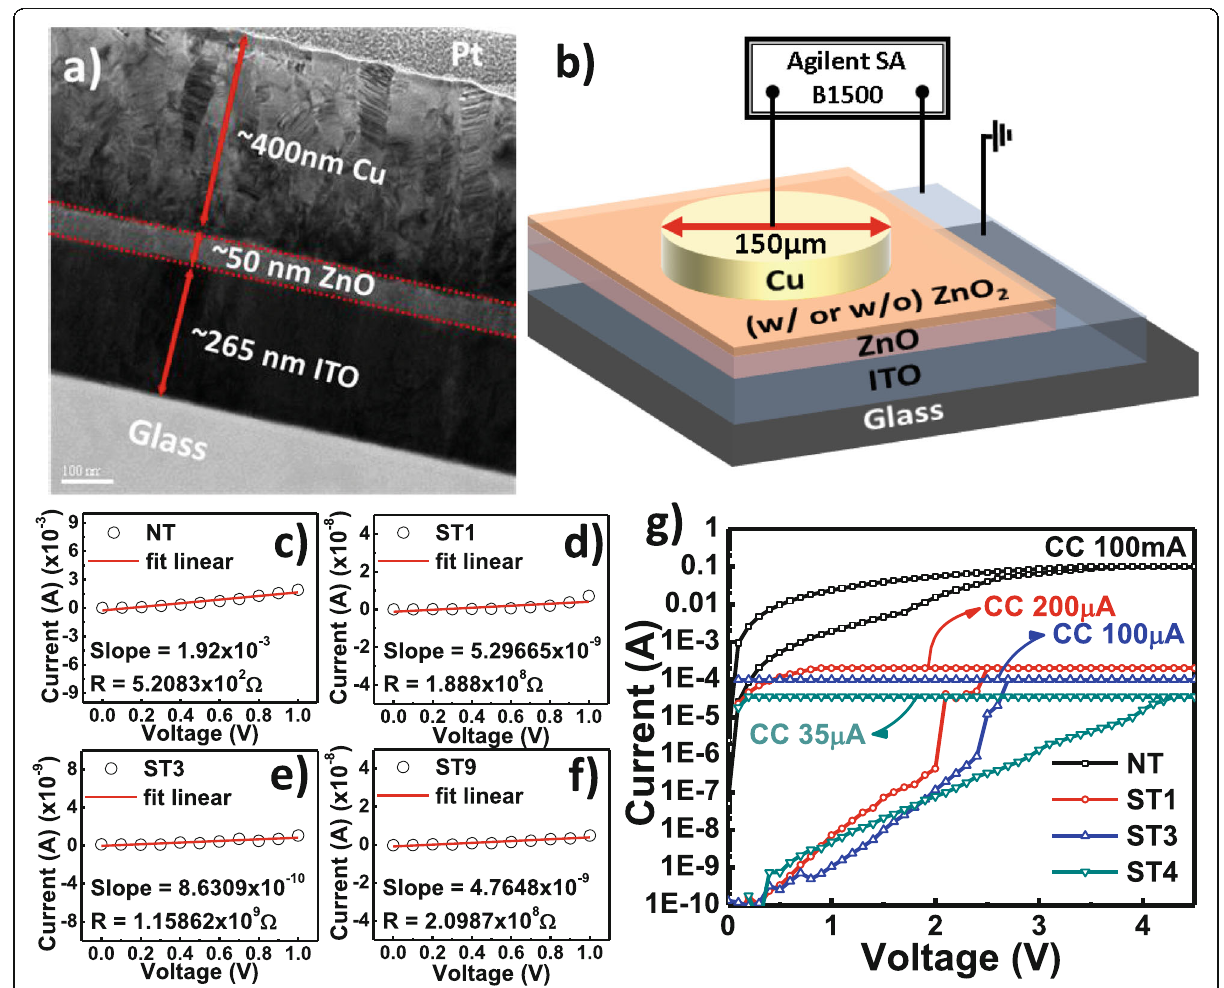
Fig. 2 a Cross-section TEM image of Cu/ZnO/ITO device. b Schematic of Cu/ZnO/ITO device. Typical I-V curve and resistance calculation of ( c ) control, ( d ) ST1, ( e ) ST3, and ( f ) ST9 devices. g Forming curves of the fabricated